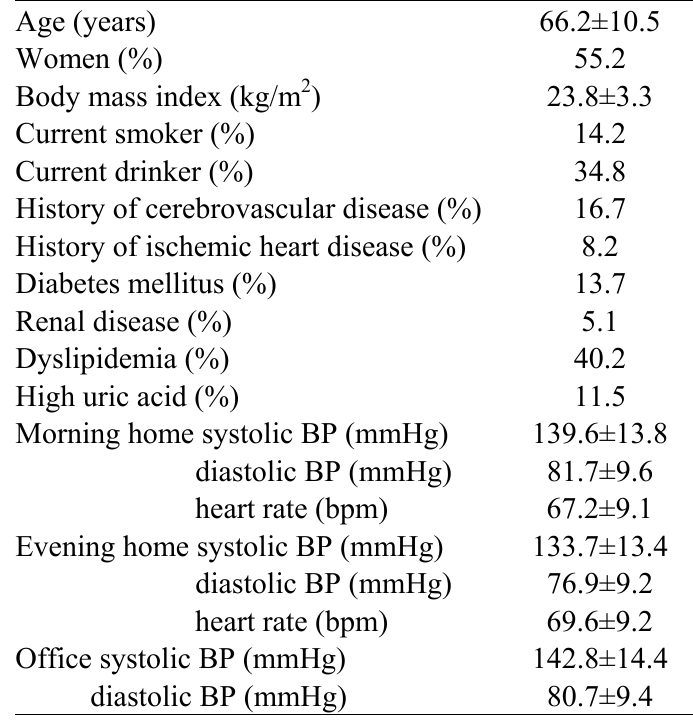
Table 1. Characteristics of study subjects.